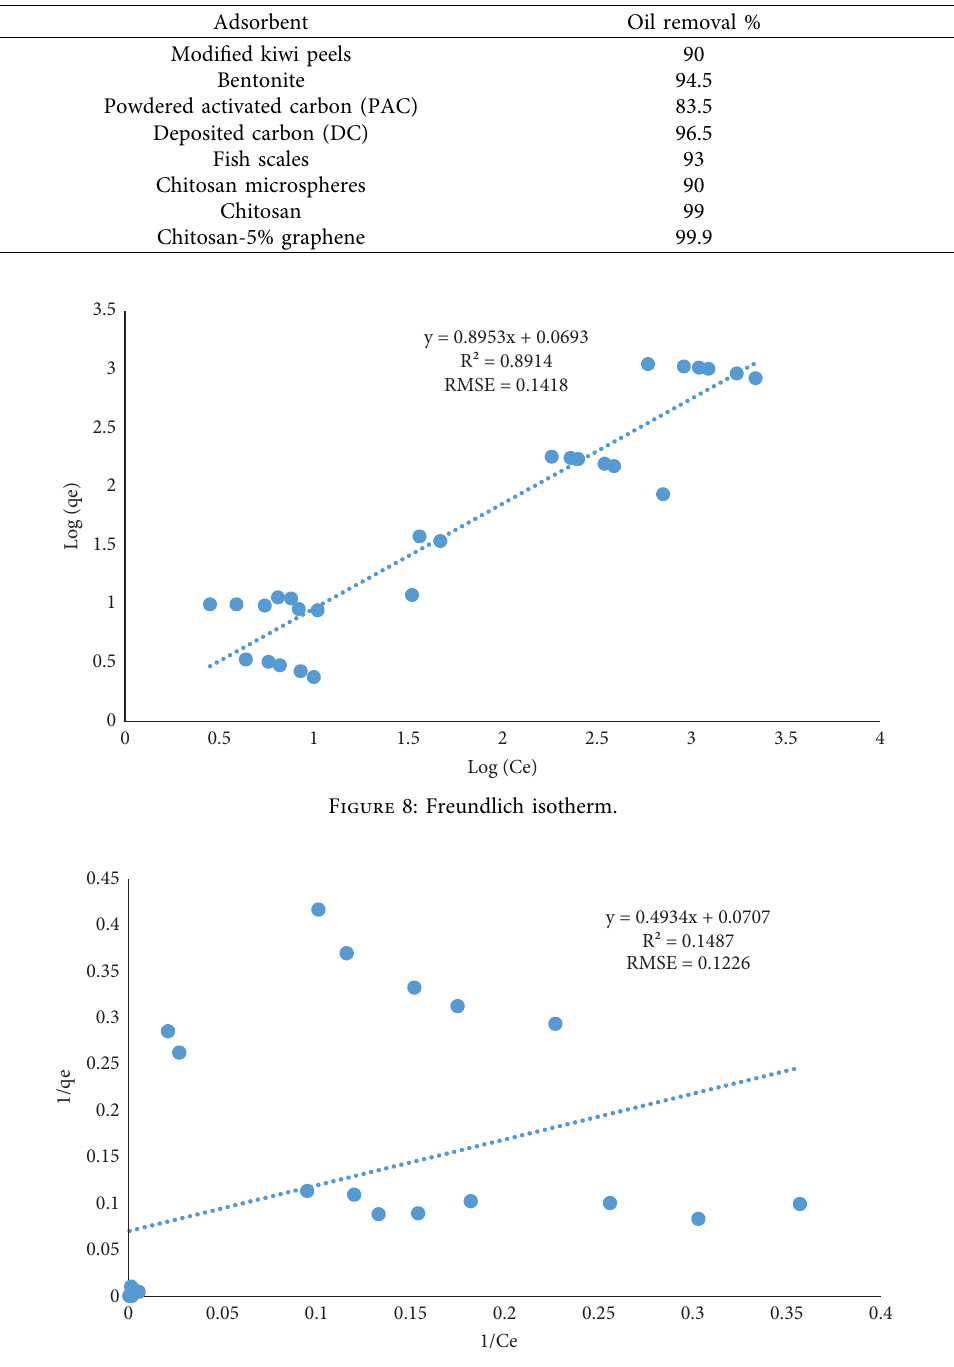
Figure 9: Langmuir